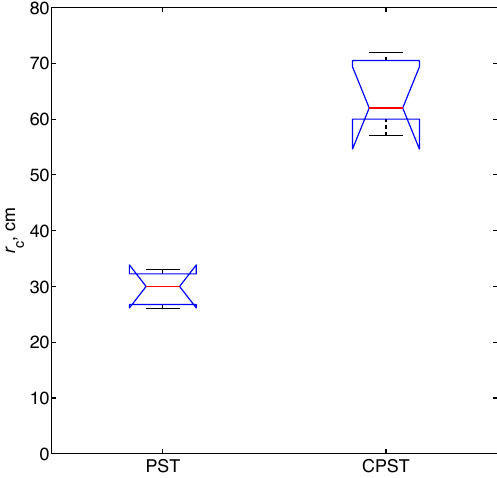
Figure 4. Critical cut lengths ( r c ) for edge (PST) and CPSTs. All tests fully propagated and were done side by side (19/12/2012; Ta- ble 1). Median values are red lines, boxes are 25th/75th percentiles, and whiskers are ranges. Nonoverlapping notches show signifi- cantly different groups at the 5% level from the Kruskal–Wallis test ( p = 0 . 009). N = 5 PSTs and 5